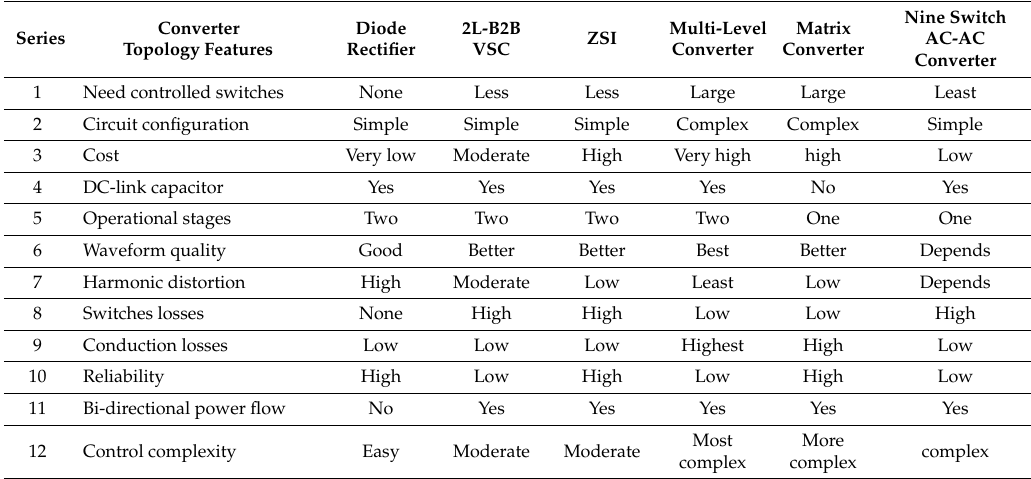
Table 7. Comparison of mainstream power converter topologies.